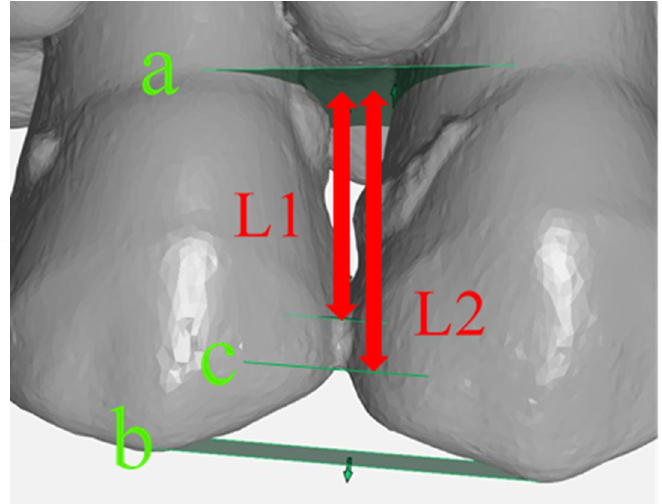
Figure 4. Example of the interdental area (IA) 15 / 14: Cemento-enamel junction plane ( a ), occlusal plane ( b ), interdental contact point ( c ), displayed IA (L1) in relation to the absolute IA (L2).